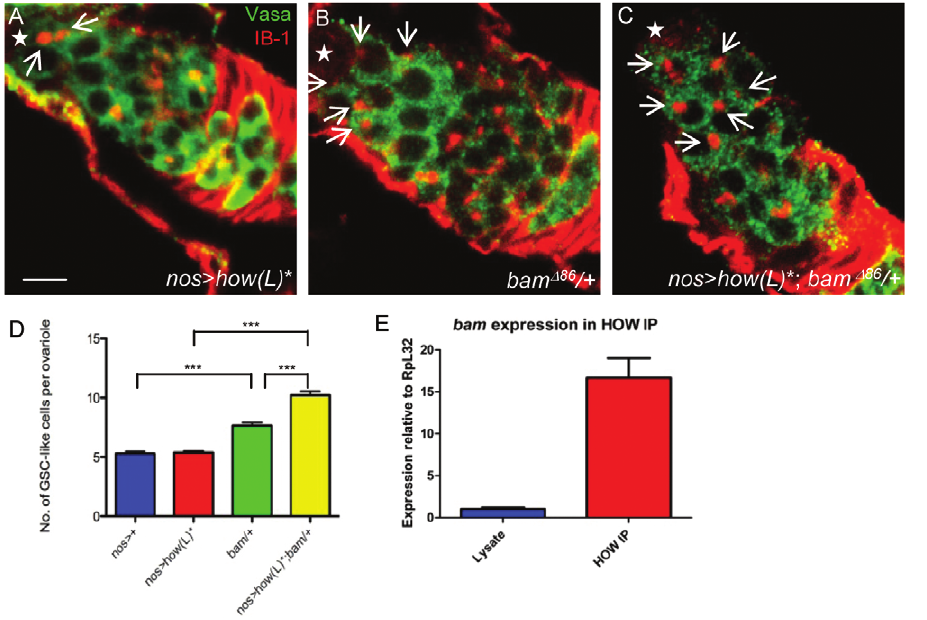
Figure 6. how(L) genetically interacts with bam . Comparison of the number of Vasa-positive germ cells with unbranched spectrosomes (white q ). ( A ) Overexpression of a second, weaker UAS:how(L) transgene in the female germline ( nos . how(L)*) does not produce germaria with extra numbers of GSC-like cells compared to wild type ovarioles. ( B ) bam D 86 / + germaria contain an increased number of GSC-like cells. ( C ) nos -driven overexpression of the weaker UAS:how(L) transgene in a bam D 86 / + mutant background results in germaria containing more GSC-like cells compared to bam D 86 / + ovarioles. ( D ) Graphical representation showing the mean number of GSC-like cells per germaria. ( E ) HOW immunoprecipiation from ovary lysate results in a 16.8 fold enrichment of bam mRNA. Anterior direction marked (*). Scale bar 5 m m.